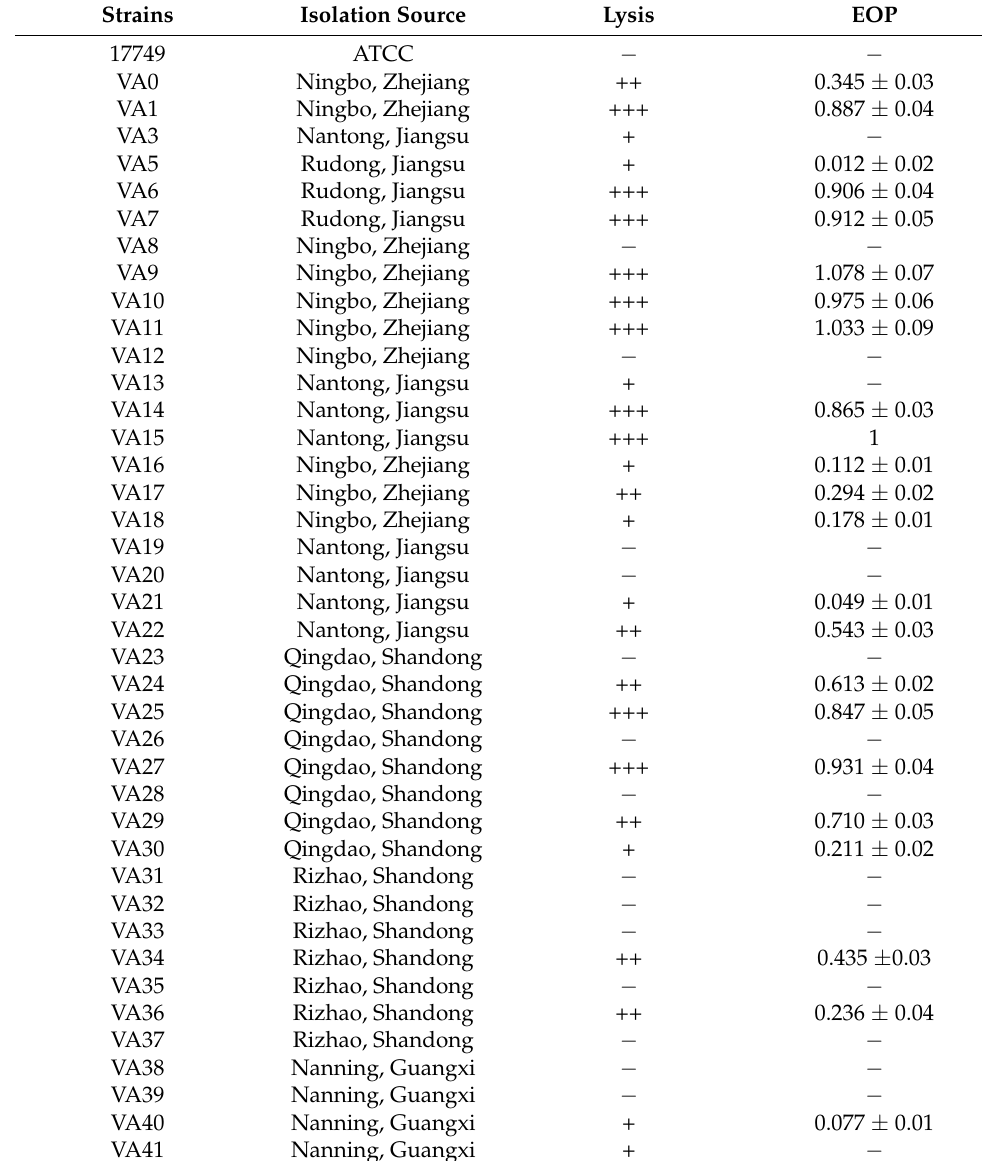
Table 3. Host range of the isolated phages to the V. alginolyticus